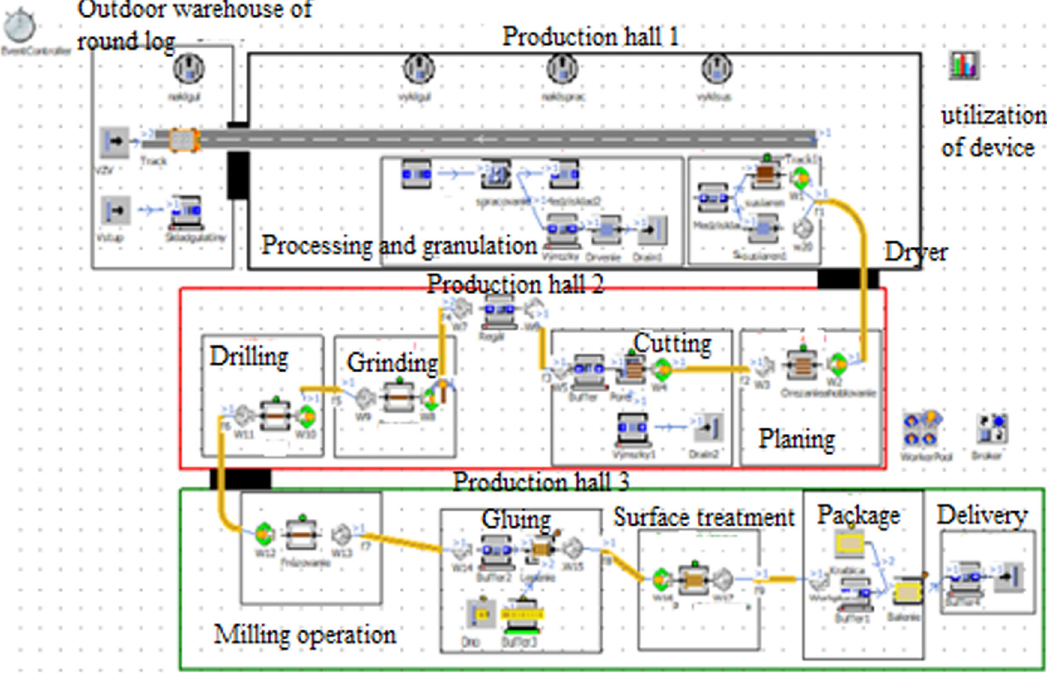
Figure 7: Addition of the second dryer to the production process. Source: